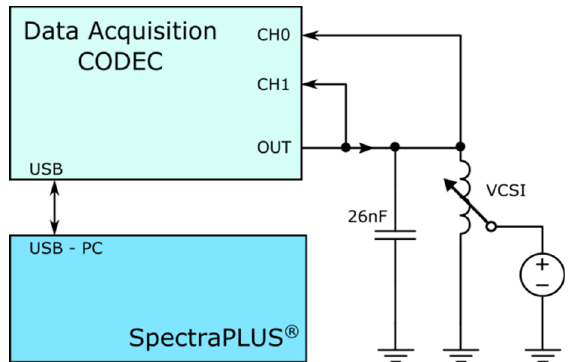
Figure 5. Experimental setup based on virtual vector network analyzer.